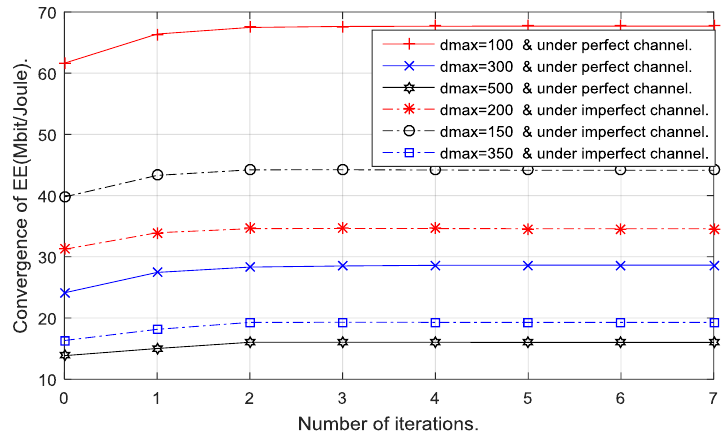
Figure 13. Convergence of energy efficiency.